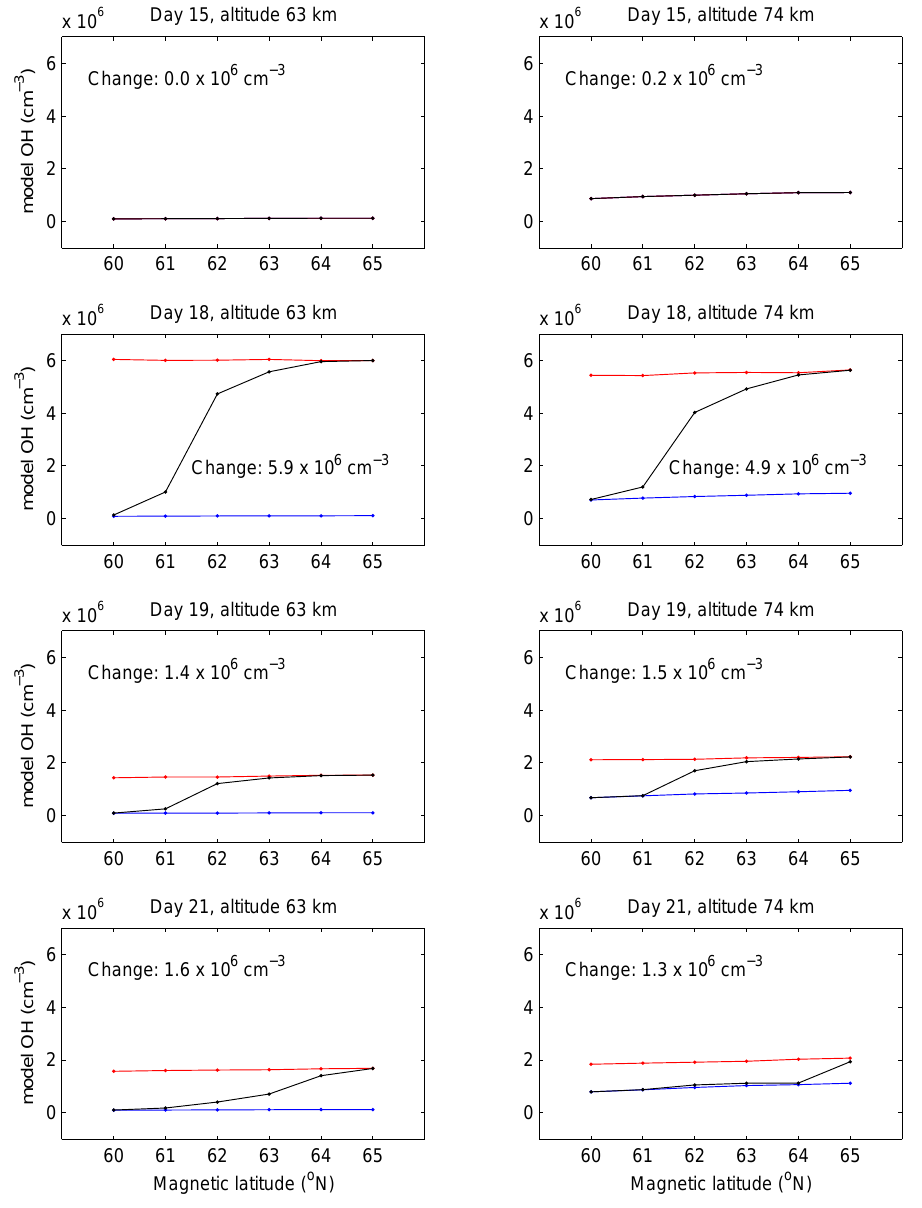
Fig. 6. Left panels: model OH at 63km for selected days, the CTR (blue), CUT (black), and SPE (red) run results are shown at different magnetic latitudes. Change between the CTR and SPE concentrations are given for each of the panels. Right panels: Same as the left ones but at 74km